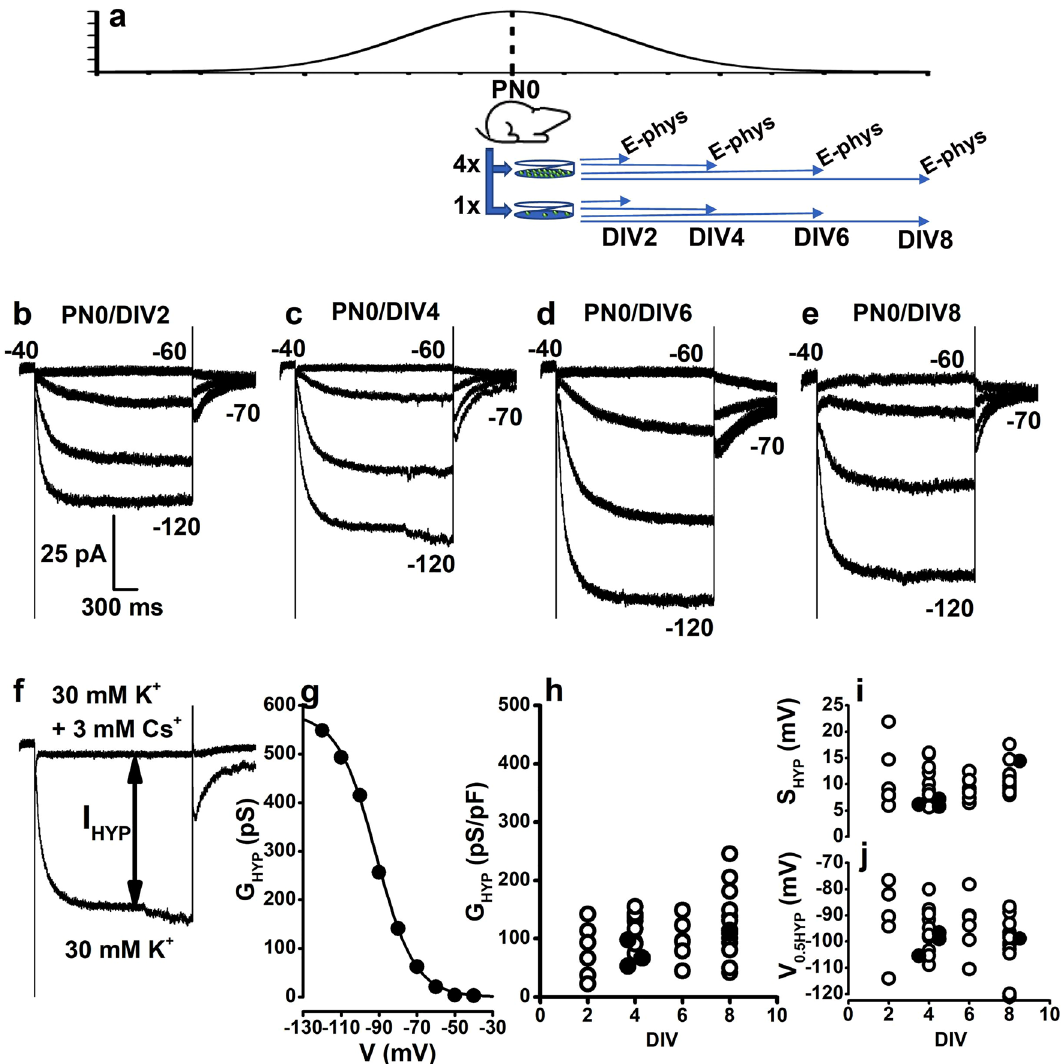
Figure 3. Functional properties of cultured rod precursors. ( a ) The Y-axis plots the rod precursor generation rate in arbitrary units. The scheme illustrates the generation of retinal cultures at 1 × and 4 × cell densities from PN0 mice. Horizontal arrows indicate the use of DIV2, DIV4, DIV6, and DIV8 cultures for patch-clamp recordings (E-phys). ( b – d ) Sweeps plot membrane currents activated in response to 2 s-long voltage steps at − 60, − 80, − 100, and − 120 mV from a holding voltage of − 40 mV in GFP + cells isolated on the day of birth (PN0) and recorded after 2 (PN0/DIV2) ( b ), 4 (PN0/DIV4) ( c ), 6 (PN0/DIV6) ( d ) and 8 (PN0/DIV8) ( e ) days in vitro (DIV). ( f ) Protocol for measuring the Cs-sensitive current (I HYP ) at steady-state (see “Materials and methods”). The double arrows line indicates the current activated by membrane hyperpolarisation (I HYP ), computed by the difference between current amplitudes in saline with either 30 mM KCl or 30 mM KCl + 3 mM CsCl. ( g ) Filled symbols plot membrane conductance (G HYP ) values generated by diving I HYP for the driving force (see “Materials and methods”). G HYP is plotted, after normalisation to membrane capacitance, as a function of activating voltage. The continuous line plots the best-fitting Boltzmann function used to estimate activation parameters (see “Materials and methods”) for the PN0/DIV4 cell above. ( h – j ) Symbols plot parameters generated by best-fits to individual cells voltage-dependent activation curves similar to panel ( f ). Circles plot G HYP ( h ) normalised to membrane capacitance, the inverse slope factor S HYP ( i ), and the half-activation voltage V 0.5HYP ( j ) for PN0/DIV2 (N = 6), PNO/DIV4 (N = 11), PN0/DIV6 (N = 6), and PN0/DIV8 (N = 13) cells cultured at 1 × (open circles); PN0/DIV4 (N = 3) and PN0/DIV8 (N = 1) cells cultured at 4 × cell density (filled circles). Two-way ANOVA indicated non-significant effects of DIV (F = 1.42953 with 3, 32 df: P = 0.25233) and cell density (F = 1.11282 with 1 and 32 df: P = 0.29937) on G HYP